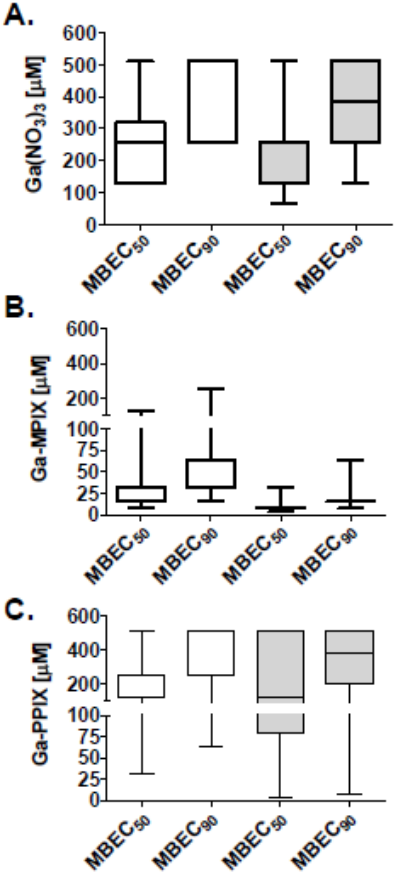
Figure 4. Activity of Ga-MPIX and Ga-PPIX against biofilms of MDR A. baumannii isolates. Biofilms of isolates of A. baumannii ( n = 13) were grown on individual pegs of an MBEC device for 24 h followed by exposure to different concentrations (0–512 µM) of ( A ) Ga(NO 3 ) 3 ; ( B ) Ga-MPIX; or ( C ) Ga-PPIX for 24 h in the iron deplete medias, MHB II (0.3 g/L) (un-shaded boxes) or RPMI1640 (shaded boxes). Plots show the concentrations (µM) required to reduce viable bacteria within biofilms of individual isolates by 50% (MBEC 50 ) and 90% (MBEC 90 ) to untreated controls. Boxes represent medians; whiskers represent range of strains tested.